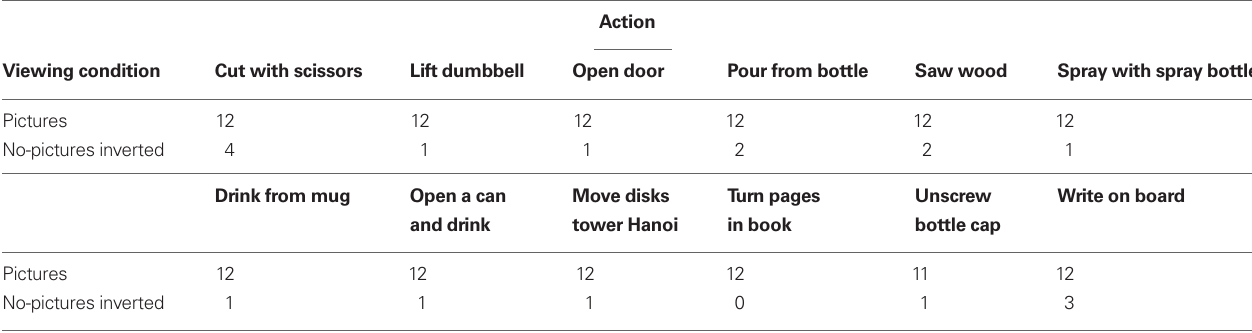
Table 2 | Number of correct verbal descriptions of the actions.